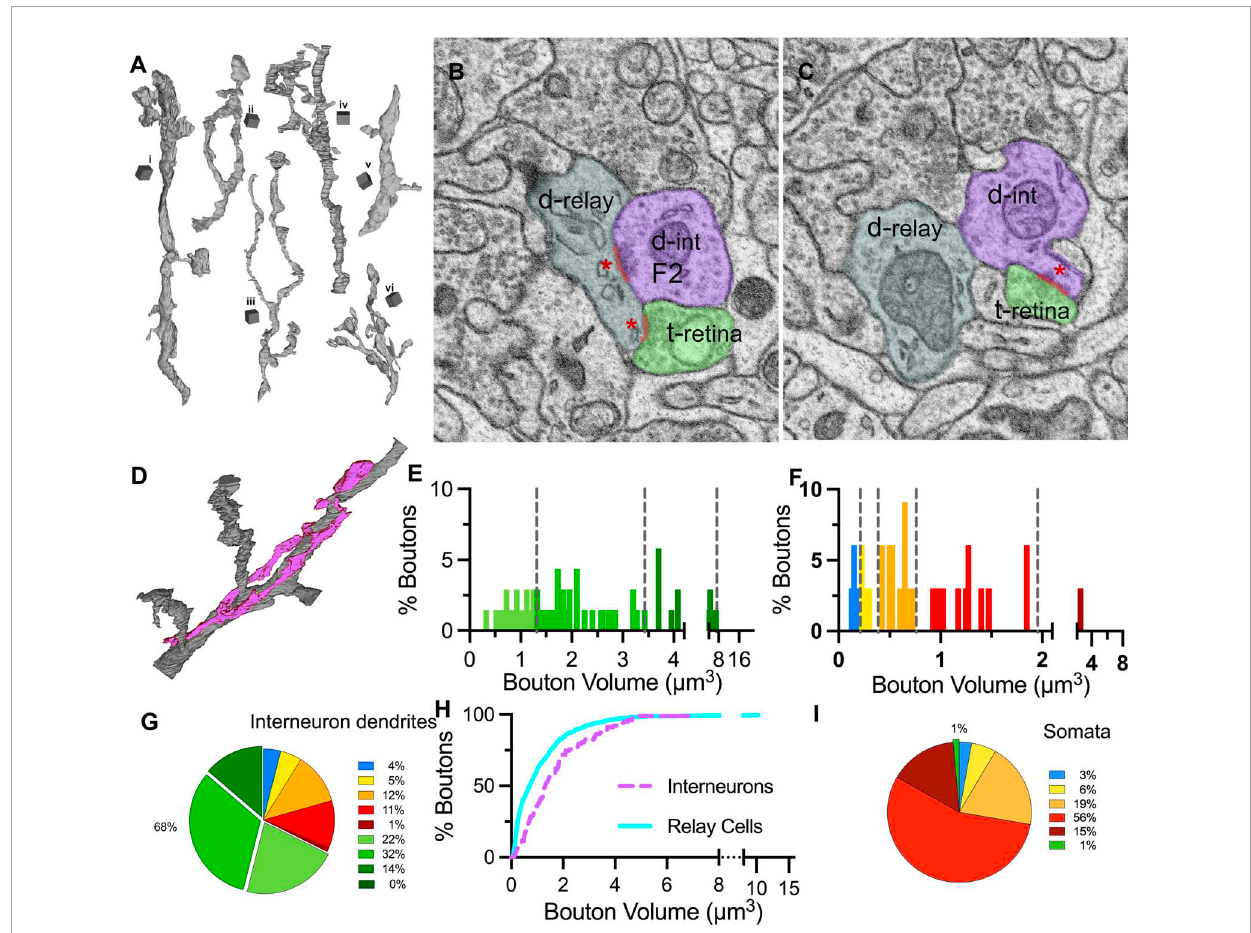
FIGURE8 Distribution of bouton types on interneuron dendrites and somata. (A) 3D reconstructions of six (i–vi) interneuron dendrite segments. Cubical scale bar represents 1 µ m × 1 µ m. Interneuron dendrites have varying calibers and display many varicosities and appendages. (B,C) SBEM images across the two near-adjacent cross-sections of an interneuron dendrite (d-int/ F2; pseudocolored in purple), a retinal bouton (t-retina, light green) and a relay dendrite (d-relay; blueish gray). Three synapses of the triad are marked with a red line and a red asterisk at the postsynaptic sites. (D) Interneuron dendrite segments (purple) often traveled along a relay dendrite (gray) and engaged in multiple triadic arrangements. (E) The cutoff values obtained in the unbiased terminal sampling are used for volume-sorting of distinct retinal terminals synapsing on interneurons. The largest-sized retinal terminals are not represented in this dataset. (F) The cutoff values obtained in the unbiased terminal sampling is used for volume-sorting of distinct non-retinal terminal subpopulations synapsing on interneurons. Two medium-sized, presumed inhibitory subpopulations represent the majority of non-retinal inputs. (G) The relative contributions of nine bouton subpopulations as synaptic inputs to interneuron dendrites. Retinal boutons provide close to 70% of inputs to interneurons, whereas corticothalamic and brainstem inputs constitute fewer than 10% of synapses. (H) Cumulative frequency distribution of bouton volumes on relay (cyan line) and interneuron (purple dashed line) dendrites. As the smallest-sized corticothalamic and brainstem inputs provide the largest portions of inputs of relay dendrites, the interneuron dendrites receive larger-sized boutons in general. (I) The relative contributions of nine bouton subpopulations as synaptic inputs onto neuronal cell bodies. By far the largest input on somata comes from inhibitory boutons, whereas retinal and corticothalamic boutons are